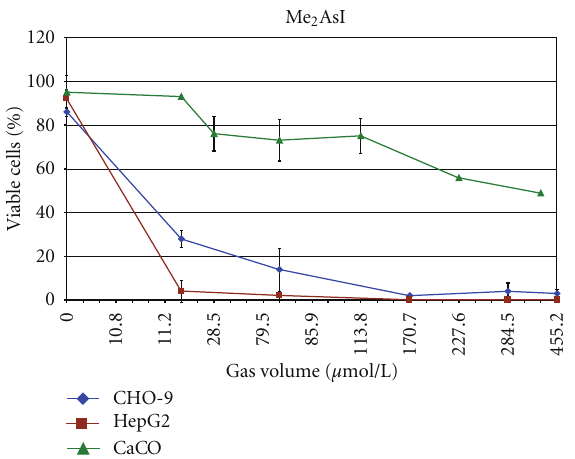
Figure 3: Cytotoxicity of Me 2 AsI in CHO-9, HepG2, and CaCo cells. The experiments were repeated three times.